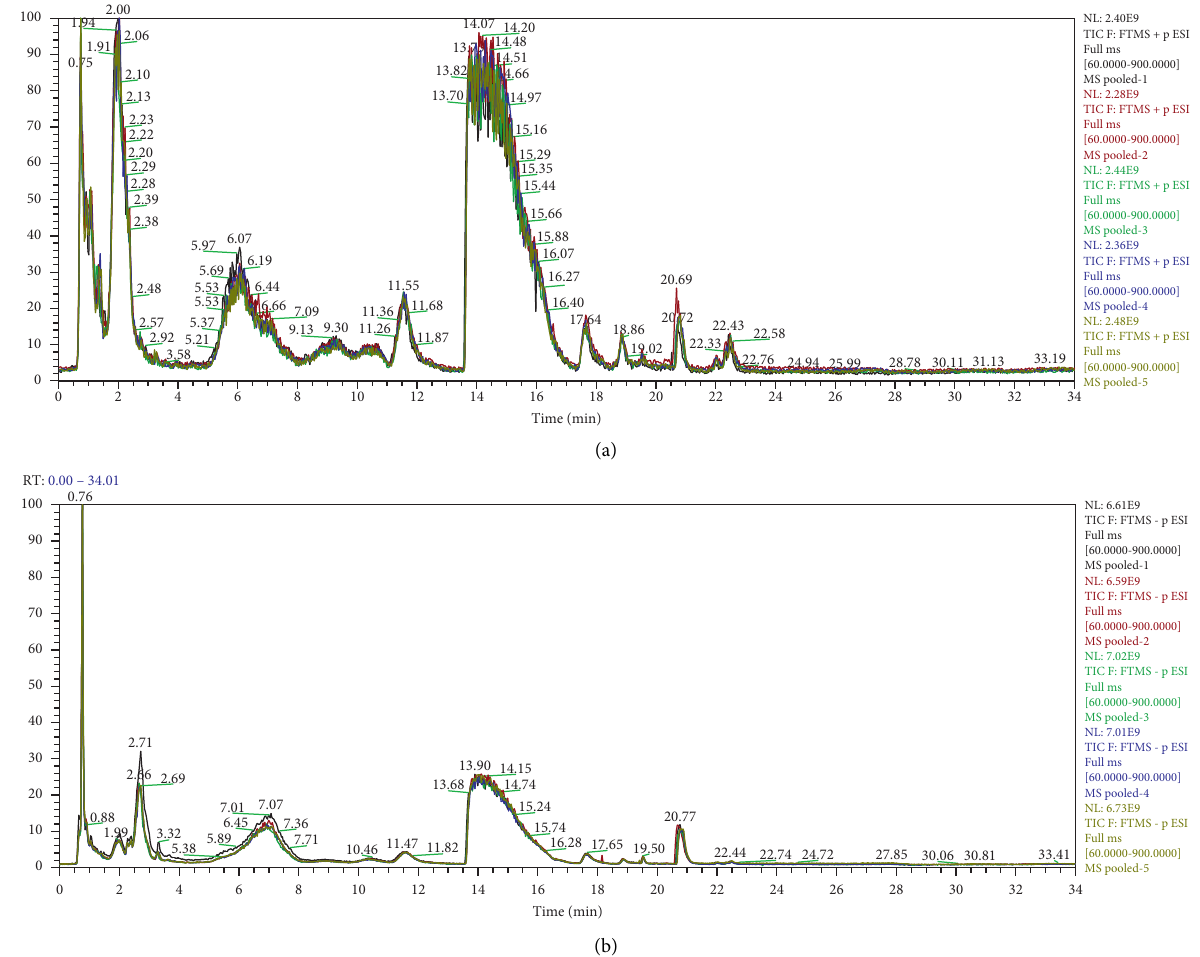
Figure 2: Liquid chromatograph-mass spectrometry results of experimental sample analyses. (a) Positive ion flow diagram for LC-MS detection of group samples. (b) Negative ion flow diagram for four LC-MS detection of group samples. LC-MS: Liquid chromatograph tandem mass